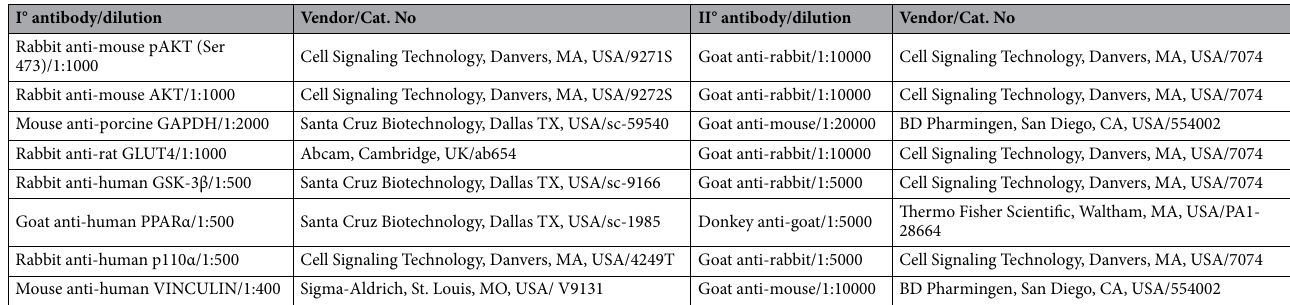
Table 2. The list of antibodies used in Western Blot